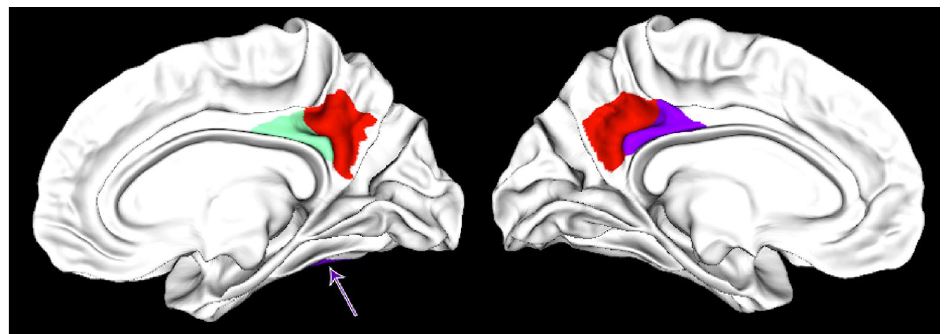
Figure 2. Regions of interest in the posterior cingulate cortex (dorsal bank of the sulcus in red, ventral bank in green and purple for the right and left hemispheres respectively) where the bold signal is differently affected by time depending on the nature of the agent. The right ventral fusiform region can be seen in purple on the bottom of the left brain (pointed by an arrow).